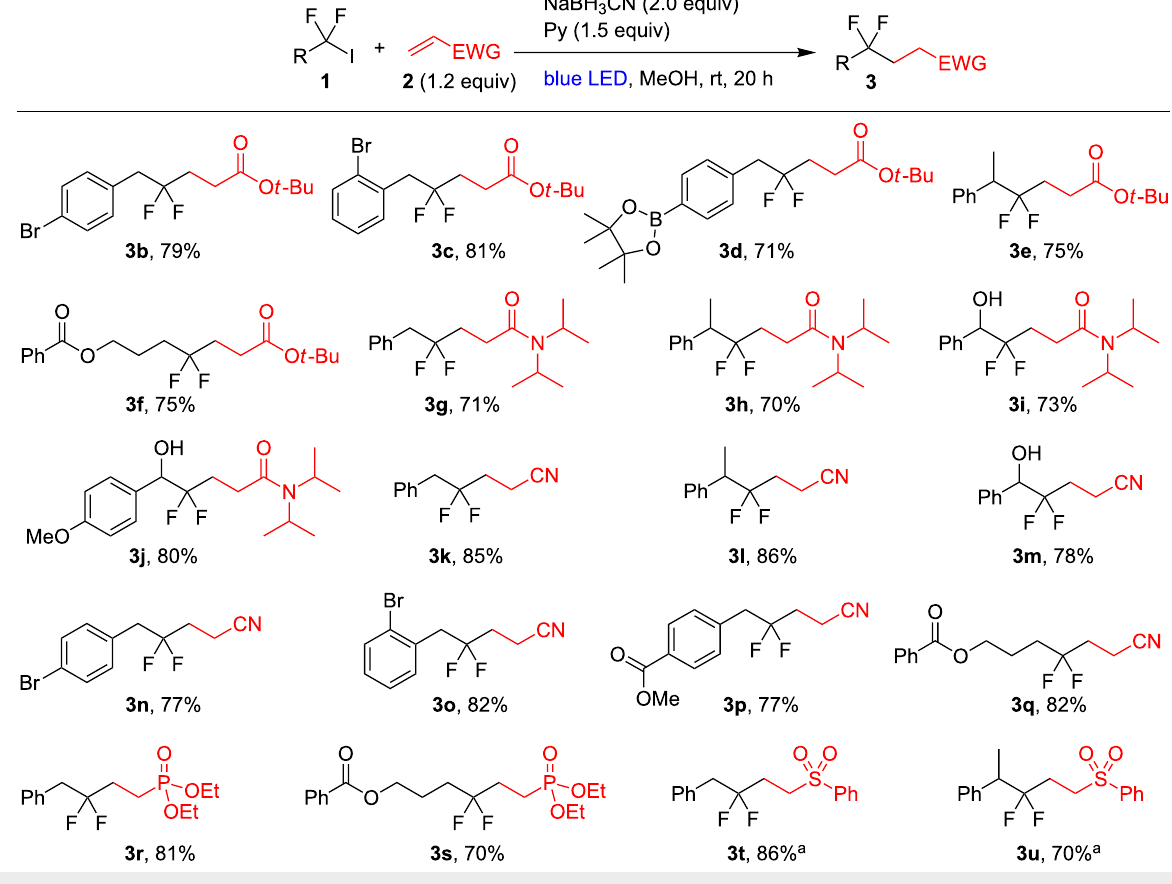
Figure 1: Difluoroalkylation of alkenes. Isolated yields are shown. a 2 equiv of the alkene were